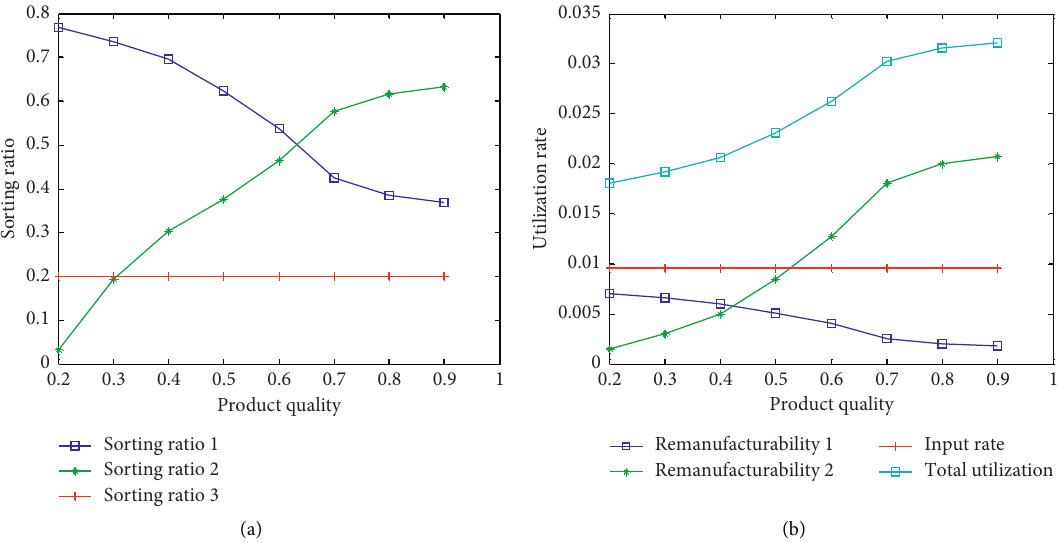
Figure 11: The variation of product quality as an influencing factor. (a) Product quality and sorting ratio. (b) Product quality and utilization rate.